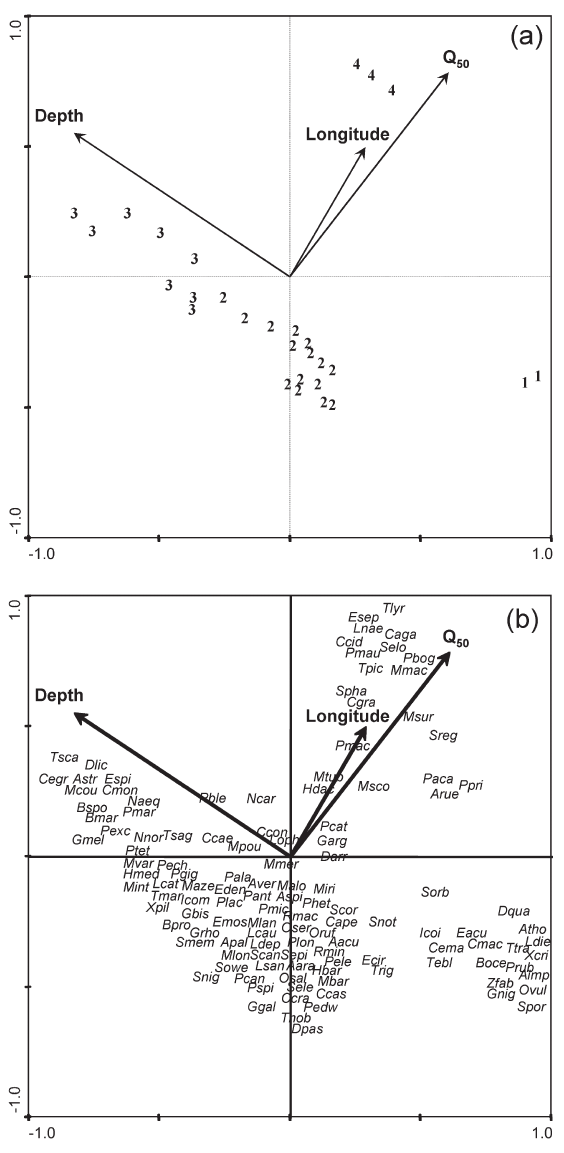
F IG . 4. – Canonical correspondence analysis (CCA) showing the bi- dimensional ordination of (a) hauls and (b) species. Superimposed vectors represent the environmental variables. Cluster groups: 1, Outer Shelf; 2, Upper Slope; 3, Middle Slope; 4, Seco de los Olivos seamount. Species codes are given in Table